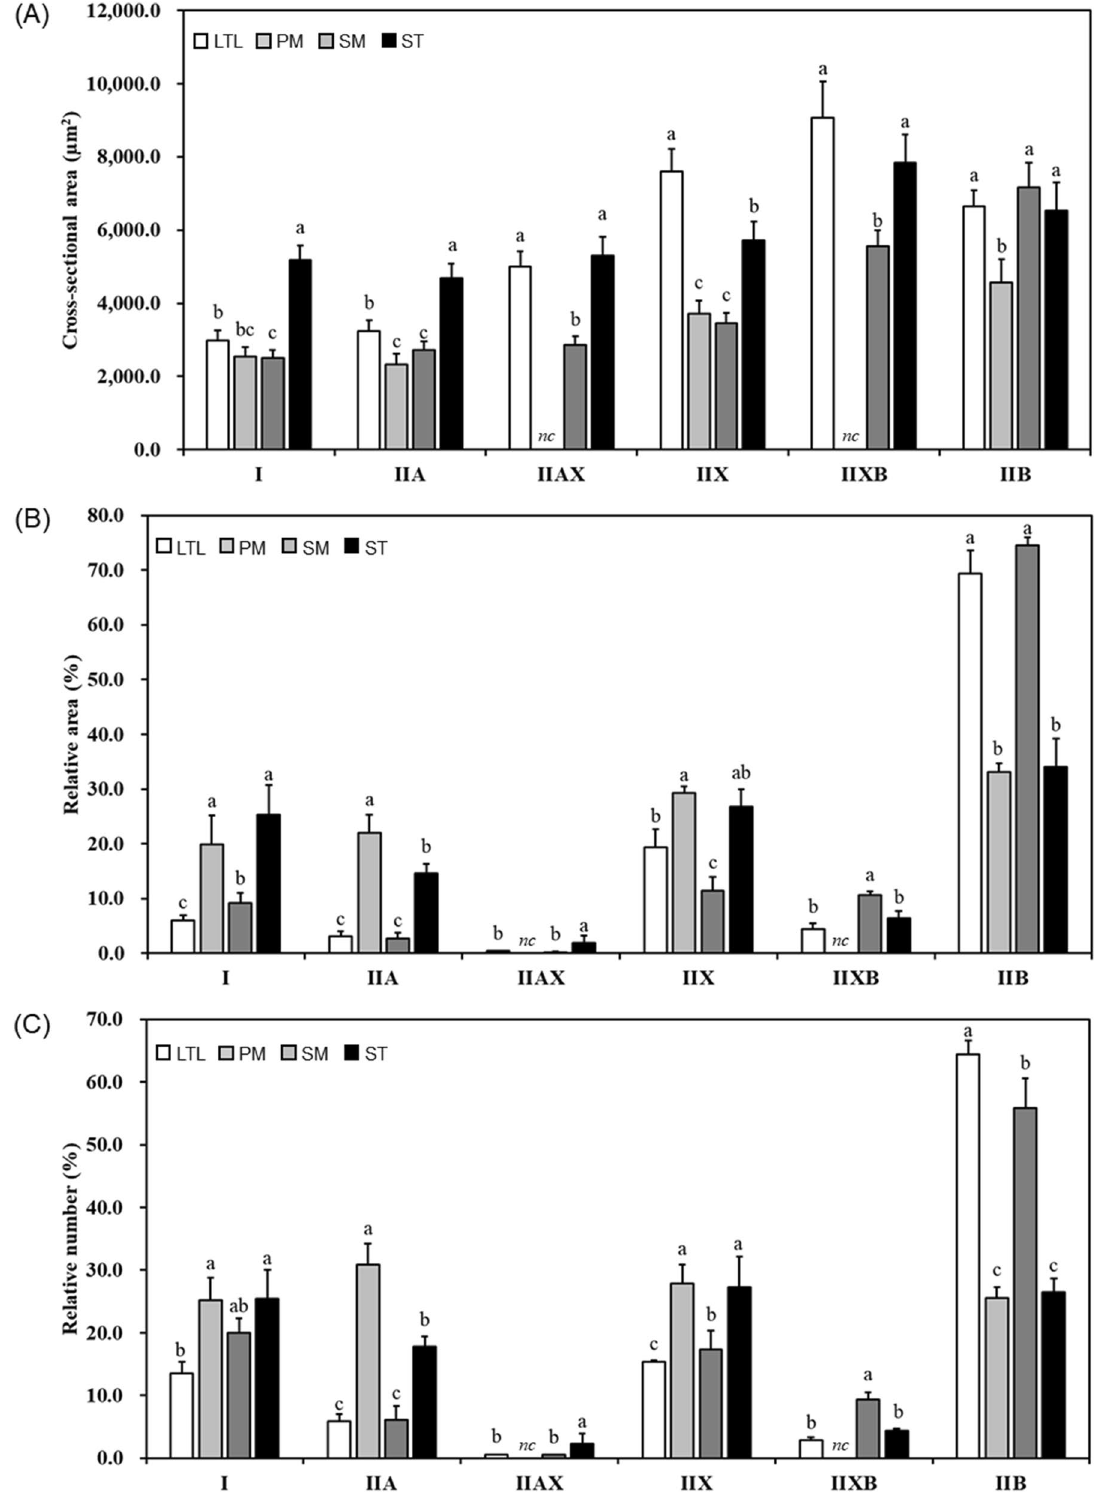
Figure 2. Comparison of muscle fiber characteristics between porcine skeletal muscles. ( A ) Cross-sectional area. ( B ) Relative area of muscle fiber. ( C ) Relative number of muscle fiber. LTL, M. longissimus thoracis et lumborum ; PM, M. psoas major ; SM, M. semimembranosus ; ST, M. semitendinosus , nc , not considered. Muscle fiber types (I, IIA, IIAX, IIX, IIXB, and IIB) were classified by four anti-myosin heavy chain antibodies as shown in Fig. 1. Different letters (a–c) on the bar indicate significant differences between muscle types within the same muscle fiber type ( P <